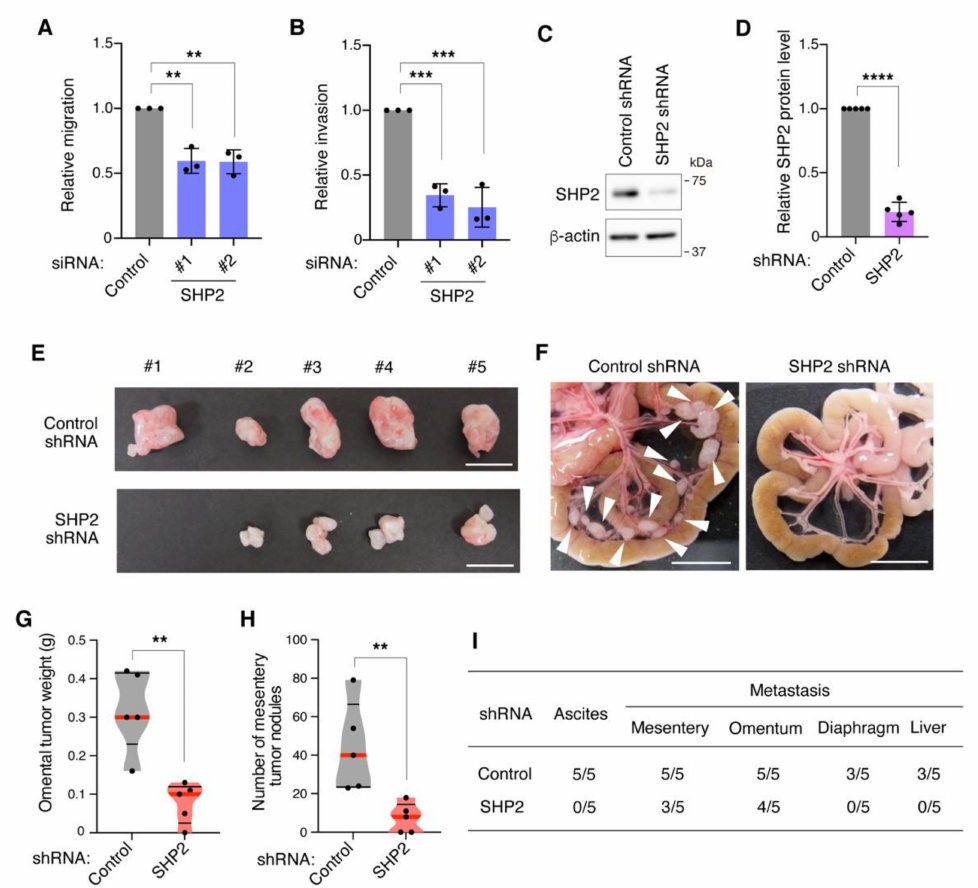
Figure 4. SHP2 is required for malignant phenotypes of Met-addicted DGC cells. ( A , B ) 58As9 cells were transfected with control or SHP2 siRNAs for 1 day and examined for their migration ( A ) and invasion ( B ) by Transwell assays. Bars, SD ( n = 3). **, p < 0.01, ***, p < 0.001. ( C ) 58As9 cells expressing control or SHP2 shRNA were subjected to immunoblot analysis. ( D ) SHP2 expression was quantitated with immunoblot data. Bars, SD ( n = 5). ****, p < 0.0001. ( E , F ) 58As9 cells expressing control or SHP2 shRNA were intraperitoneally injected into nude mice. Macroscopic images of omental tumors ( E ) and mesentery ( F ) at 15 days after injection are shown. Scale bars, 1 cm. Arrowheads denote mesentery tumors. ( G , H ) Omental tumor weight ( G ) and the number of mesentery tumors equal to or larger than 1 mm in diameter ( H ) are shown in violin plots. Red lines denote medians and black lines denote quartiles ( n = 5). **, p < 0.01. ( I ) Number of mice bearing ascites or tumors at indicated site per total number of mice